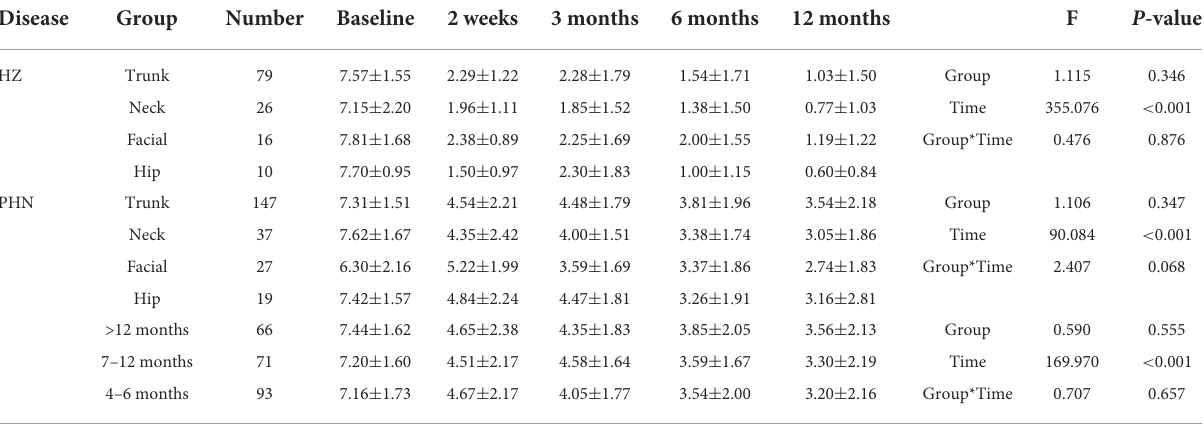
TABLE 2 Two-way repeated measures ANOVA for between group and time interactions of VAS scores in patients with HZ and PHN. Disease